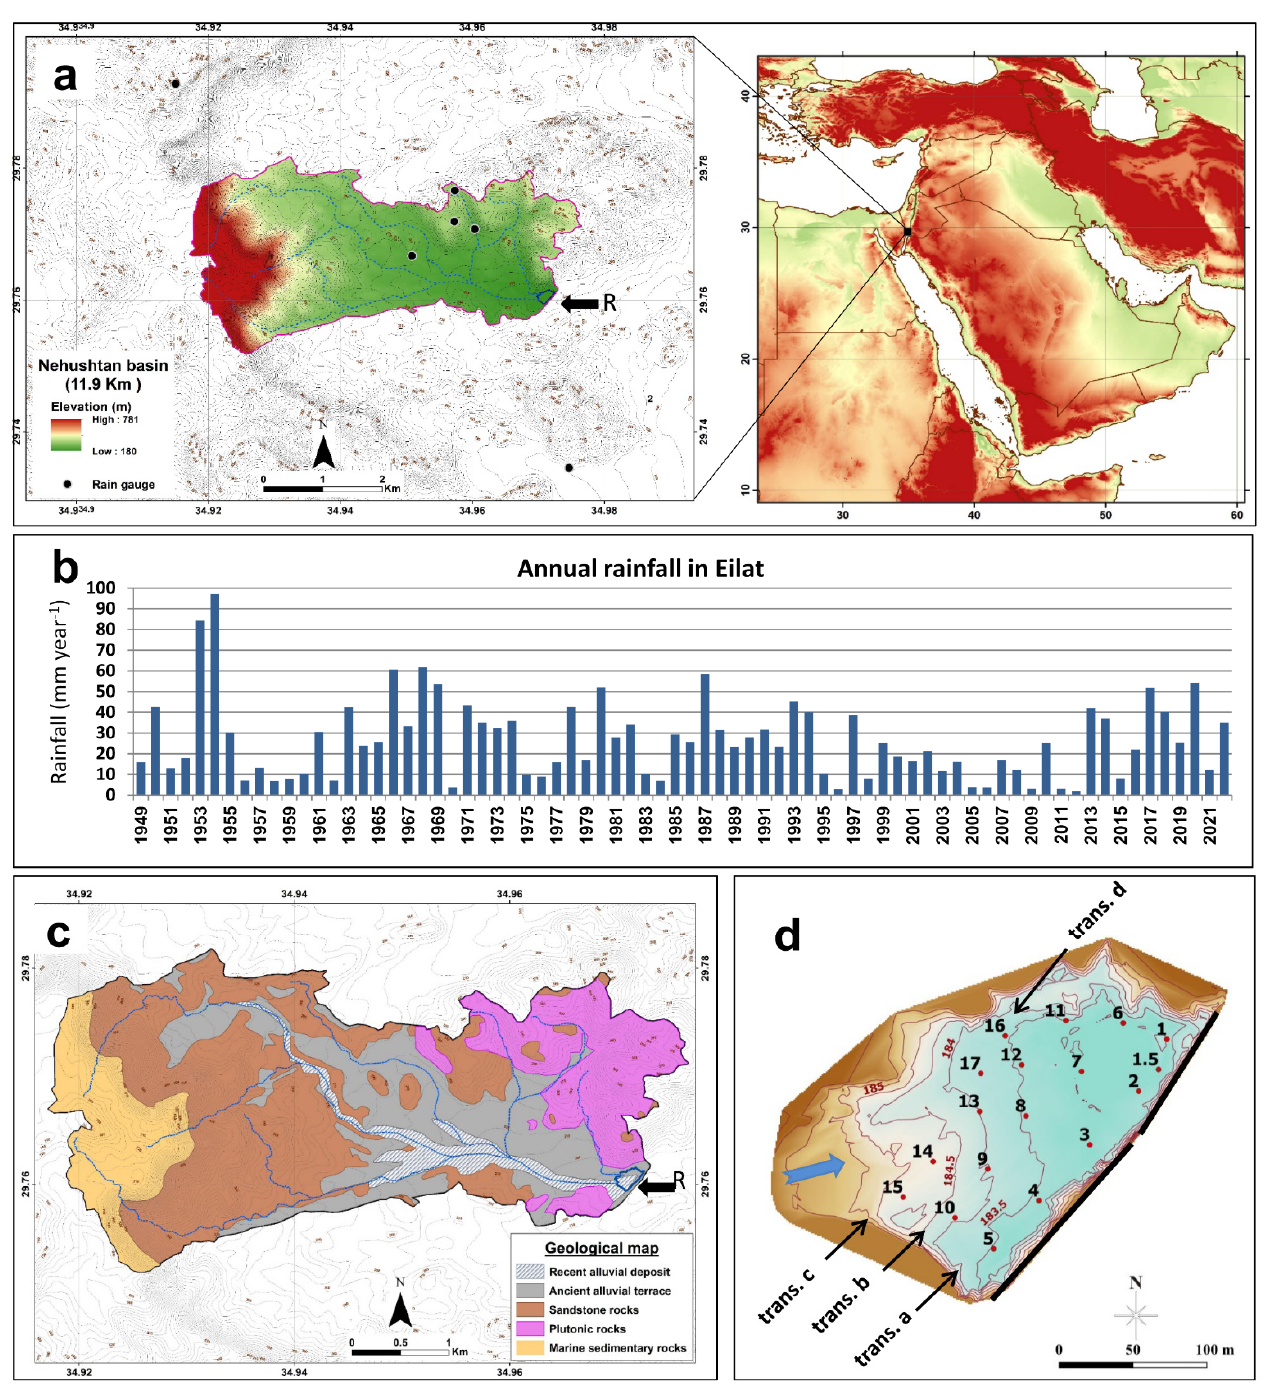
Figure 1. The study area: ( a ) The Nahal Nehushtan study site is located in the southern Negev Desert of Israel, between the Arabian Peninsula and the deserts of northeastern Africa. The main tributaries of Nehushtan catchment area (11.9 km 2 ) drain into the reservoir (“R”) and the location of six rain gauges inside and outside the basin (Black circles). ( b ) Annual rainfall in Eilat according to the Israel Meteorological Service [60]. The city of Eilat is located 23 km south of the study area. ( c ) The different lithologies in the Nahal Nehushtan drainage basin (modified from [61]). ( d ) Topographic map of the Nehushtan Reservoir following the 2015 flood event. Sediment was sampled in pits (1–17) along transects (trans. a-trans. d). The blue arrow indicates flow direction and the dam by a dashed line.